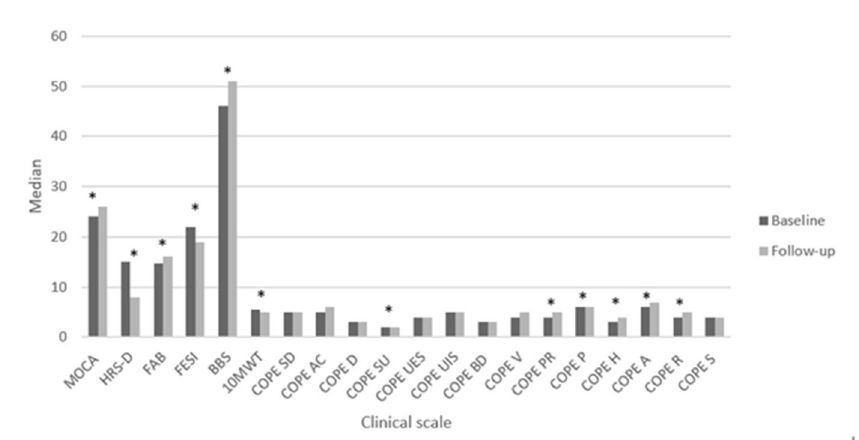
Figure 1. Bar graphs of MoCA, HRS-D, FAB, FESI, BBS, and subitems of COPE scores over time. *p < 0.05; MoCA Montreal of cognitive assessment, HRS-D Hamilton rating scale for depression, FAB Frontal assessment battery, FESI Falls efficacy scale international, BBS Berg balance scale, COPE Coping orientation to problems